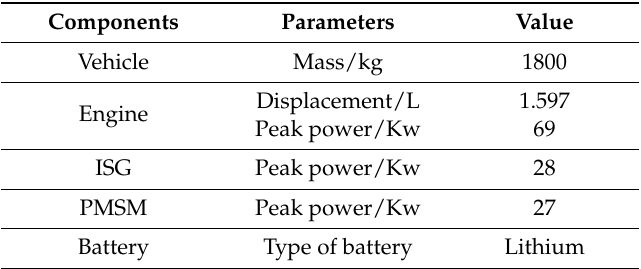
Table 1. The parameters of vehicle and key components.